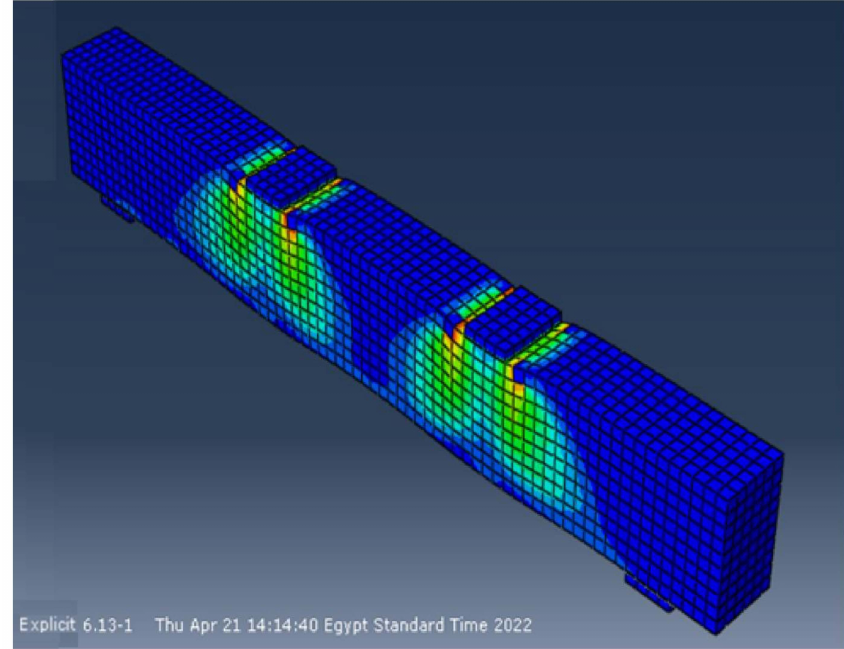
Figure 15. Final crack pattern of specimen